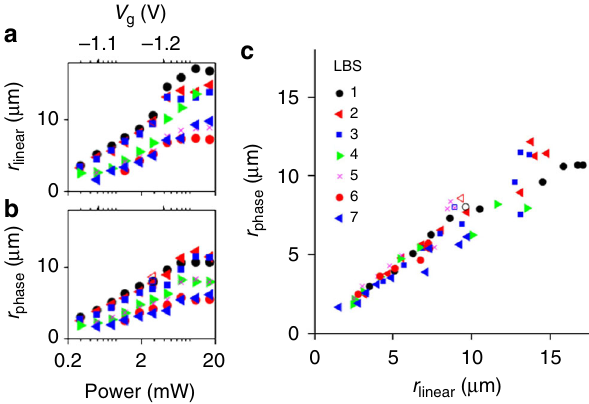
Fig. 3 Correlation between the phase shifts and polarization pattern. a The radius at which linear polarization changes sign, r linear as a function of laser power, P for different LBS. b The radius at which the phase of interference fringes shifts, r phase as a function of laser power, P for different LBS. c r phase vs r linear . Solid (open) symbols correspond to 2 µ m shift in ^ x ( ^ y ). T bath = 0.1 K. The data for different LBS and different P collapse on a universal line